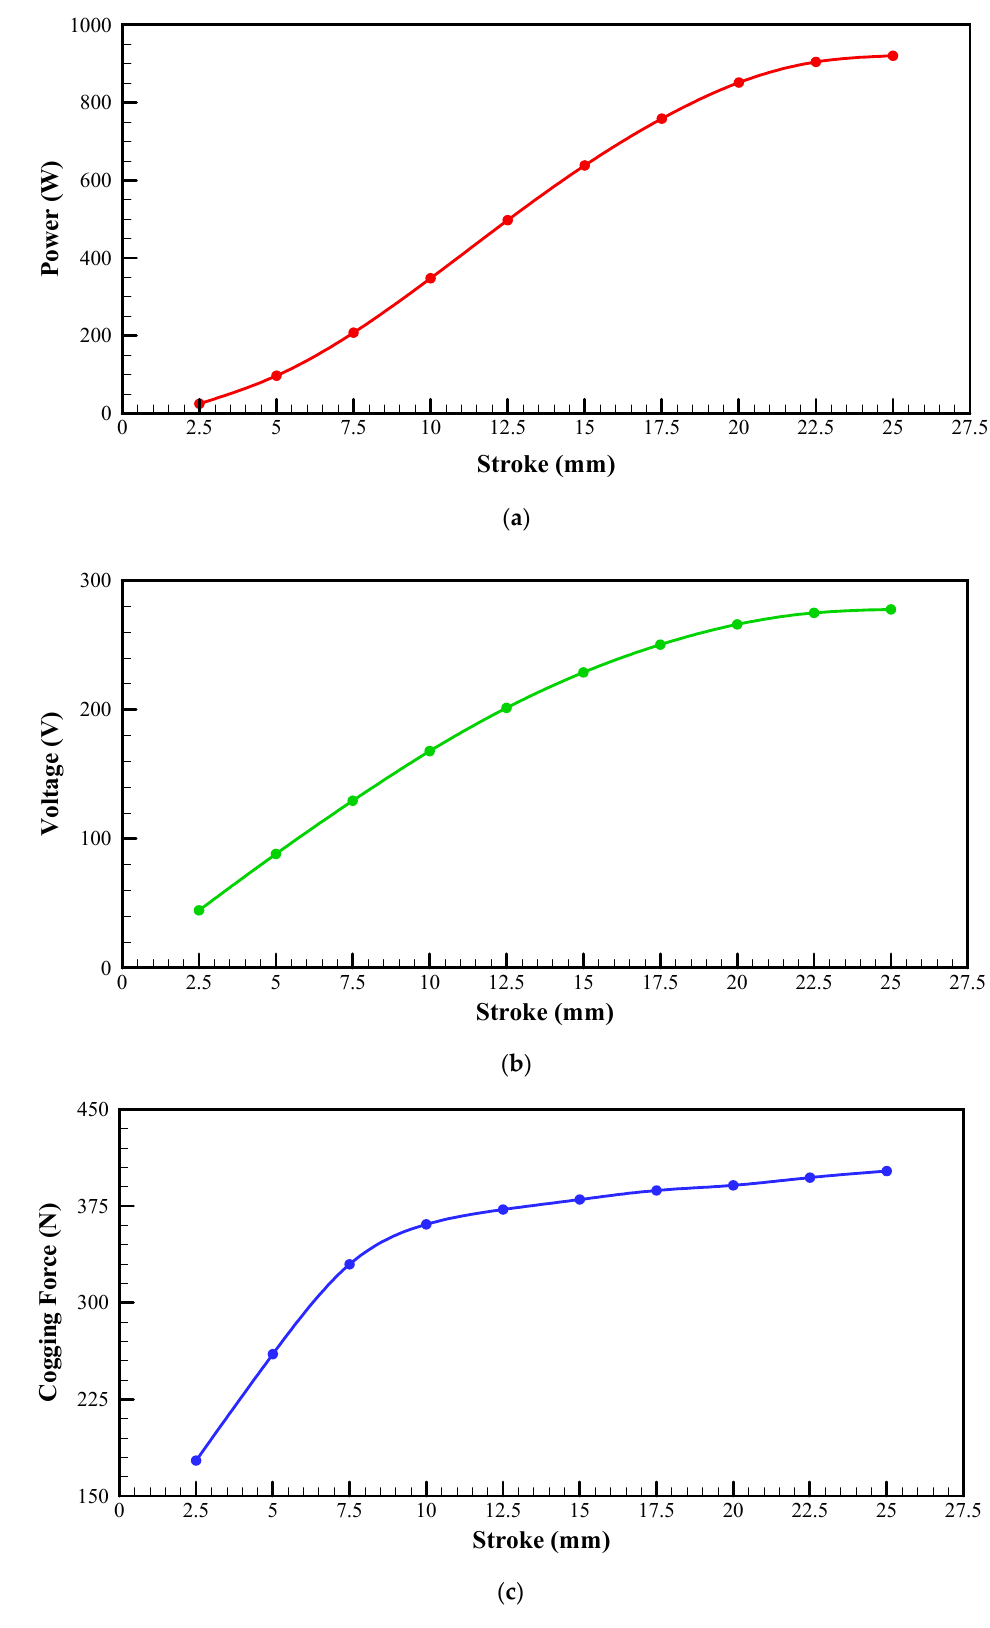
Figure 12. Influence of stroke length on ( a ) power, ( b ) voltage, and ( c ) cogging force.